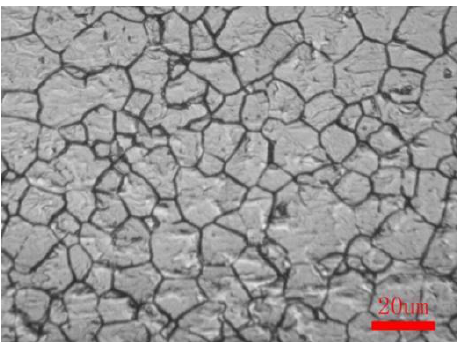
Table 1. Chemical composition of the 21-4N sheet (wt. %).